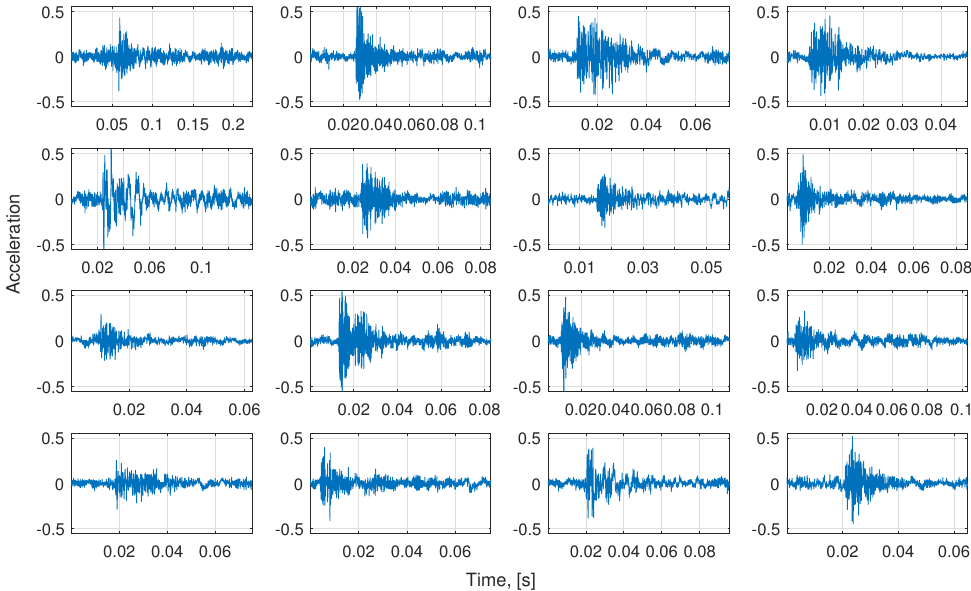
Figure 11. The exemplary impulses selected from the de-trended signal. In Figure 12 the dendrogram is presented. It is a way to visually present the structure of clustered data produced by hierarchical clustering. It allows us to confirm the result obtained in the Silhouette criterion that two classes are optimal. They are marked in the dendrogram in green and red color. One can see that even visual evaluation of the distance between two main clusters confirms the division, and that the density of subclusters packing suggests high intracluster similarity. After we use the hierarchical clustering for the spectra of these 68 segments, we obtain classes with 51 and 17